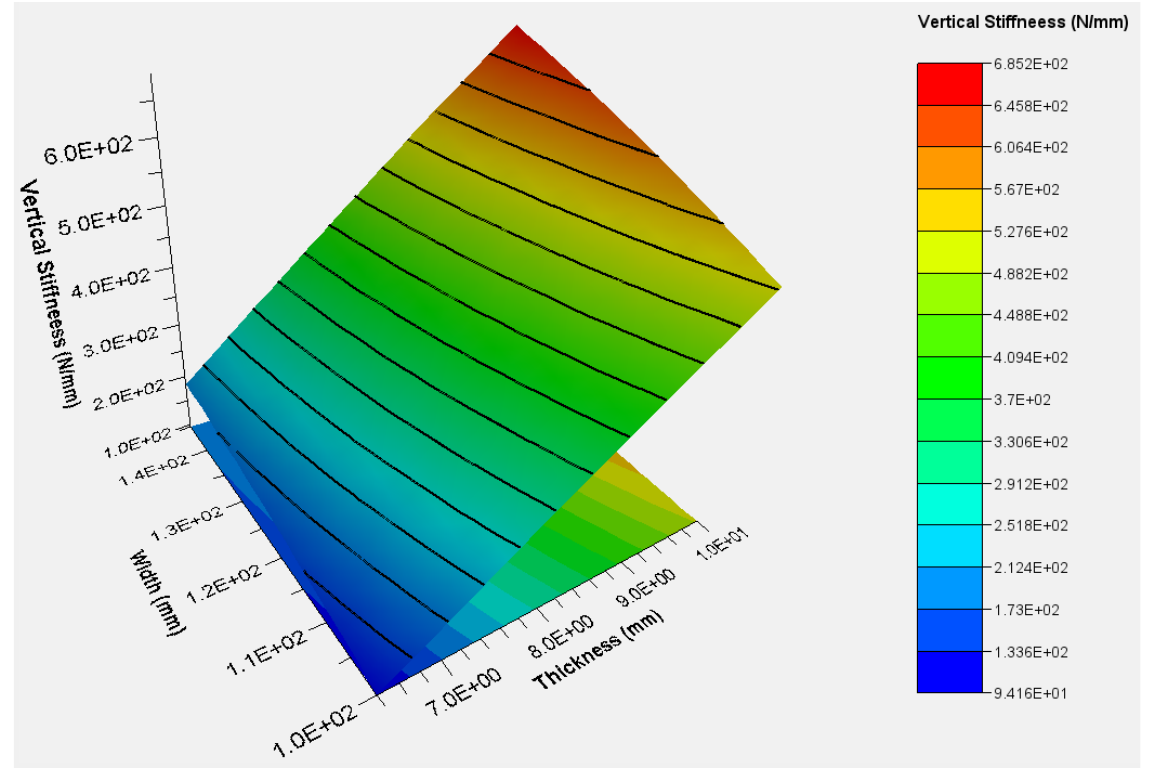
Figure 16. RSM for the vertical stiffness of the NPT as functions of the thickness and width of spokes.